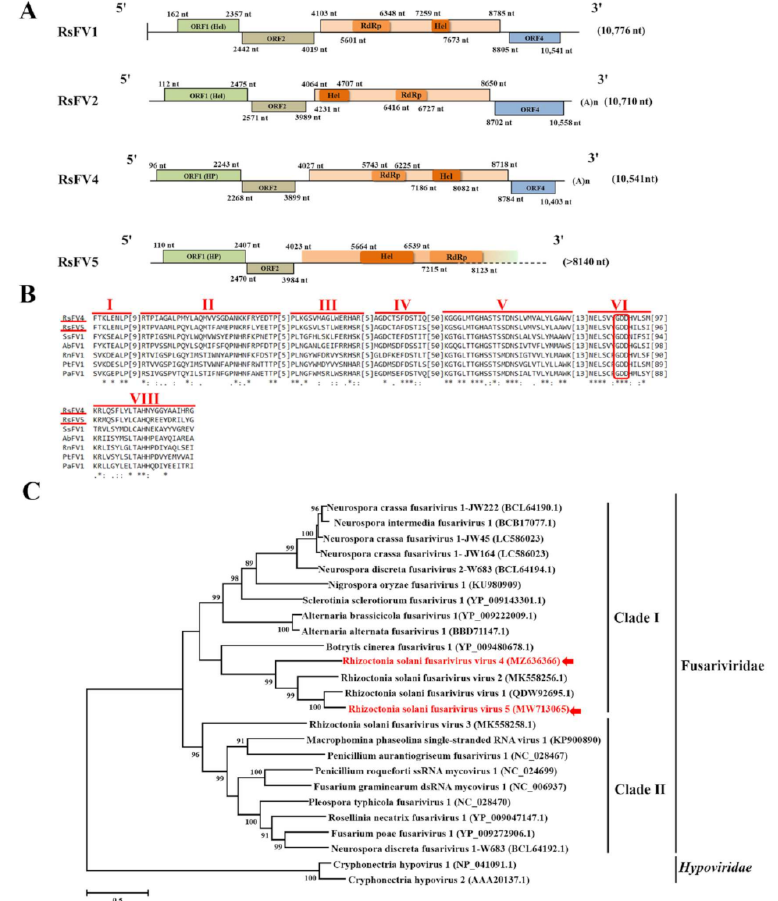
Figure 2. Genome organization, multiple alignments of amino acid (aa) sequences of RNA-dependent RNA polymerase (RdRp), and phylogenetic analysis of aa sequences of RdRp of Rhizoctonia solani fusarivirus 4 (RsFV4) and Rhizoctonia solani fusarivirus 5 (RsFV5). ( A ) Schematic diagrams represent the genome organization of RsFV4, RsFV5, Rhizoctonia solani fusarivirus 1 (RsFV1), and Rhizoctonia solani fusarivirus 2 (RsFV2), respectively. Each virus contains three or four open reading frames (ORFs). ( B ) Multiple aa sequence alignments of RdRp of RsFV4, RsFV5, and five other representative fusariviruses. Seven conserved motifs (I to VI, and VIII) are indicated. The highly conserved GDD tripeptide present in seven mycoviruses are indicated by red boxes. “*” indicates identical amino acids, “:” indicates high chemically similar amino acids, and “.” indicates low chemically similar amino acids. ( C ) Phylogenetic analysis of aa sequences of RdRp of RsFV4, RsFV5, 21 other representative fusariviruses, and two hypoviruses. Viruses in the proposed family Fusariviridae are clustered in two clades (Clade I and Clade II), and RsFV4 and RsFV5 together with RsFV1 and RsFV2 cluster together in Clade I. The names of reference and GenBank accession numbers of mycoviruses are listed in Table